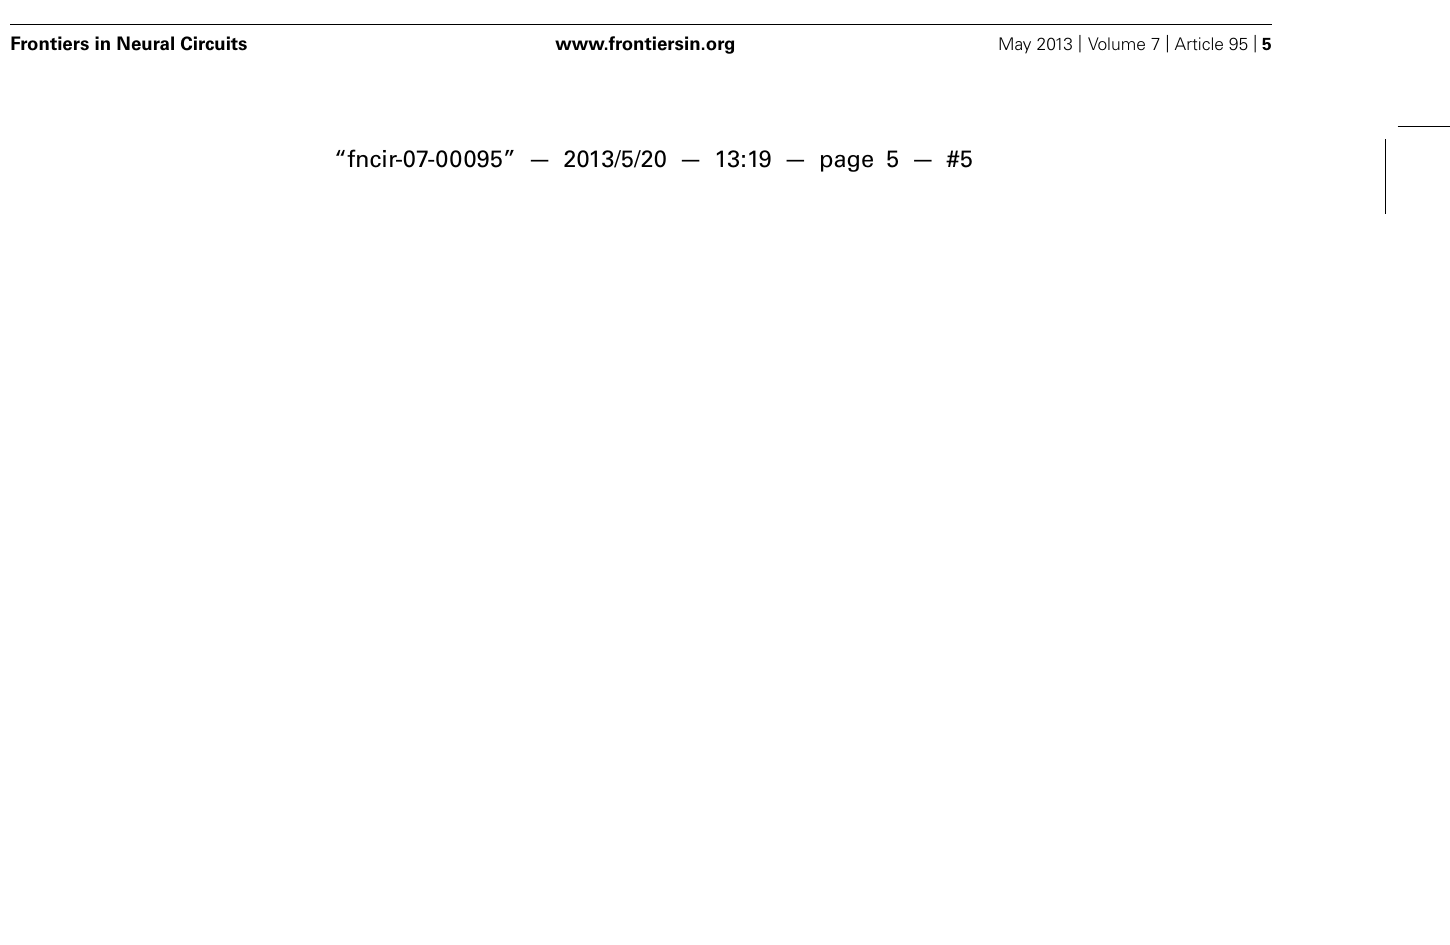
(top) and cumulative EPSC (bottom) over time. (D) Example traces of EPSCs following prolonged stimulation for 300 ms at 100, 200, 300, and 500 Hz. A plateau was established after ∼ 100 ms for all frequencies. Average current levels were measured early (left orange column) and late (right orange column) during the plateau over a 50 ms time period. Levels measured during first period are indicated by dashed lines for reference. (E) (top) Bar graph of early plateau current levels; no significant increase was observed between 300 and 500 Hz ( p < 0.05; n = 8). (bottom) Relative attenuation of plateau current levels at end of burst; no reduction was observed only at 100 Hz ( p >